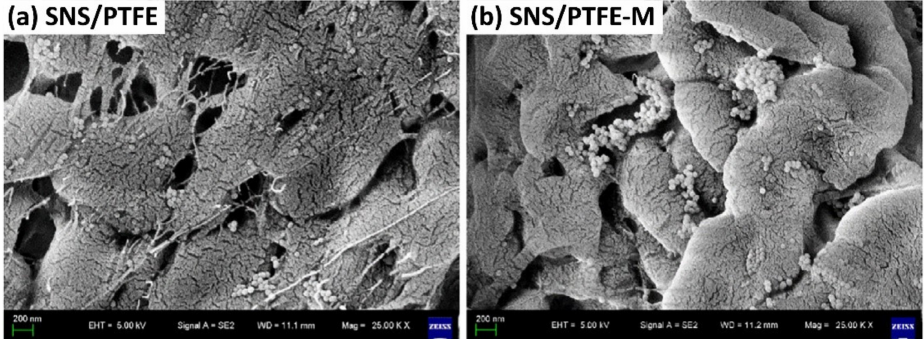
Figure 8. Scanning electron microscopic images of PTFE nanocomposites powder prepared by ( a ) in situ filling (2SNS/PTFE) and ( b ) the mechanical mixing method (2SNS/PTFE-M) (Reproduced with permission from G. Shi, Q. Wang, T. Sun, X. Yan, Journal of Applied Polymer Science; published by Wiley, 2020)